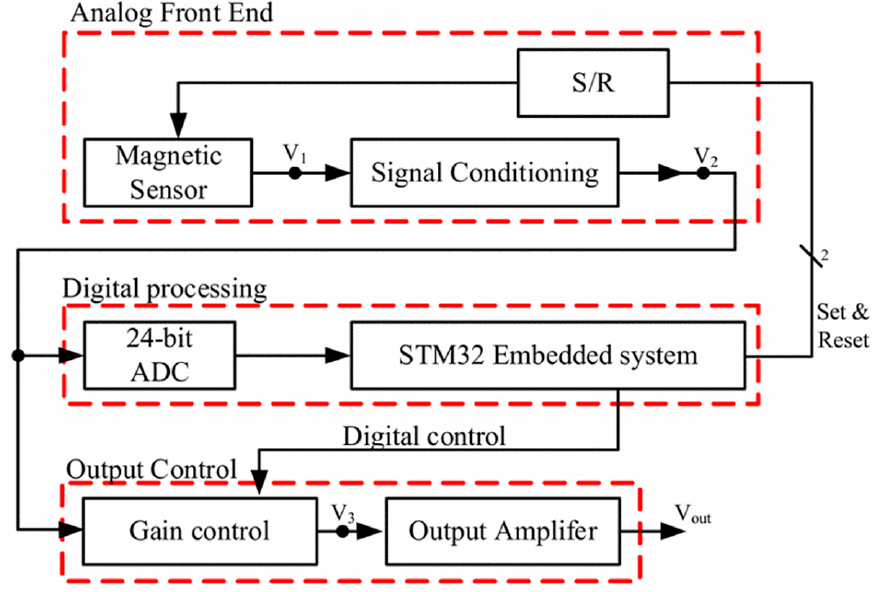
Figure 2. The function block of the proposed AMCS. In the AFE block, a three-axis magneto-resistive sensor, HMC2003, is applied to sense the magnetic field and transfer the magnetic field signal into an electronic signal. HMC2003 has a high sensitivity when measuring the low magnetic field strengths. The internal excitation current source reduces the offset drift of the magnetic sensor. Three precision low-noise instrumentation amplifiers with 1 kHz low-pass filters provide the accurate measurements while rejecting unwanted noise [17]. The signal conditioning circuit is shown in Figure 3. The signal conditioning circuit is used as the second-stage amplifier to amplify the small sensing signal. U 1 , R 1 and C 1 are applied for frequency compensation; the cut-off frequency of the signal conditioning circuit can be adjusted by the passive components, R 1 and C 1 , and is expressed as Equation (3). In the design, the cut-off frequency of the circuit is set to the third harmonic tone of 60 Hz, i.e., 180 Hz.